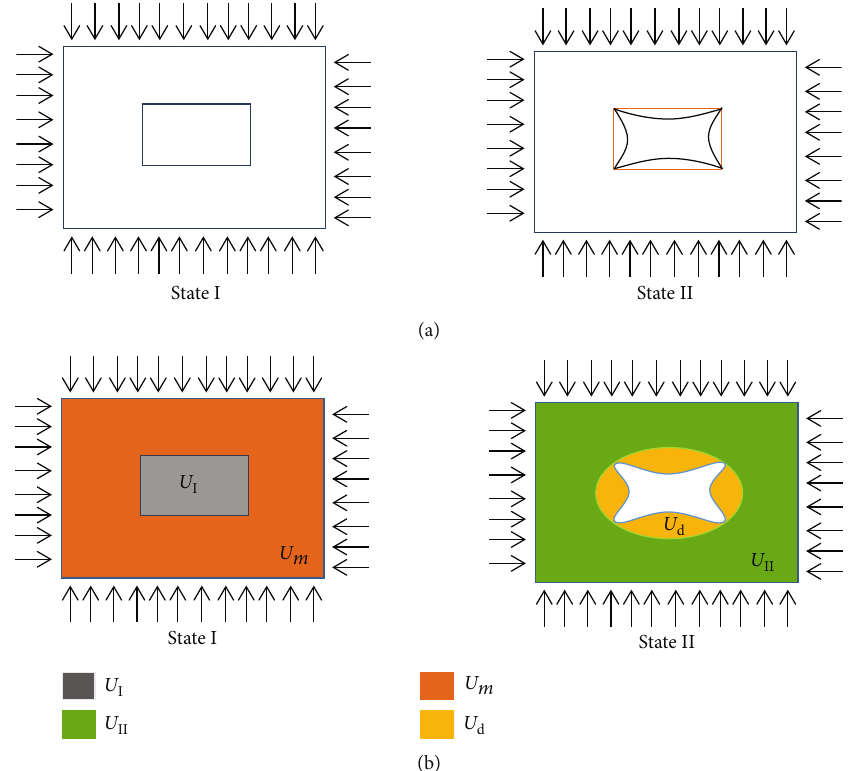
Figure 6: Schematic diagram of surrounding rock energy evolution. (a) Schematic diagram of energy input. (b) Schematic diagram of energy accumulation and